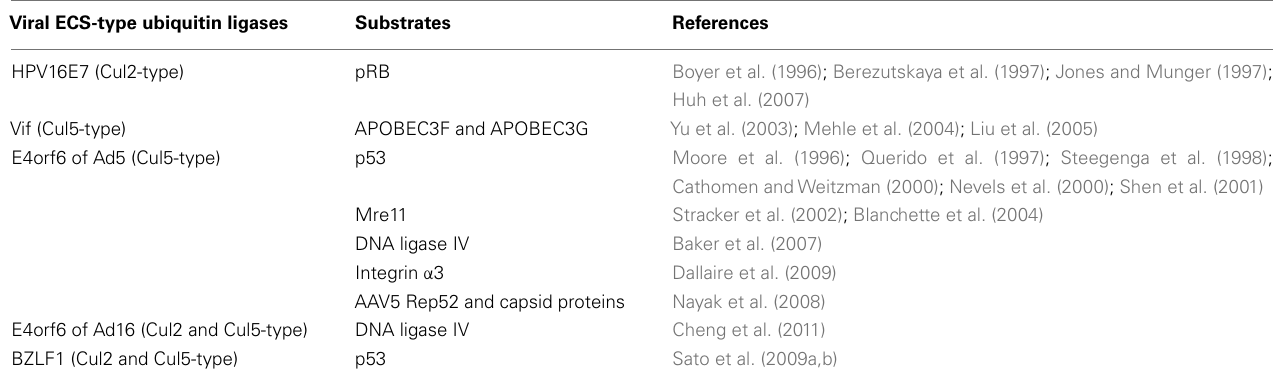
Table 3 |Viral ECS-type ubiquitin ligases and corresponding substrates. Viral ECS-type ubiquitin